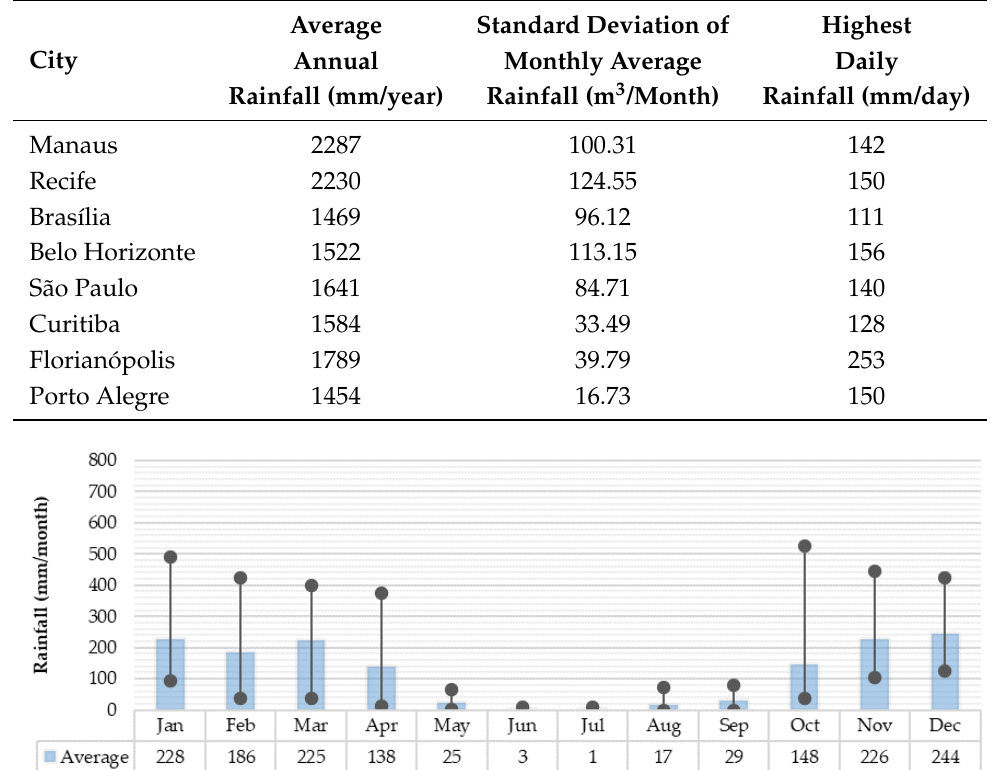
Figure 3. Average, minimum and maximum monthly rainfall in the city of Brasília over